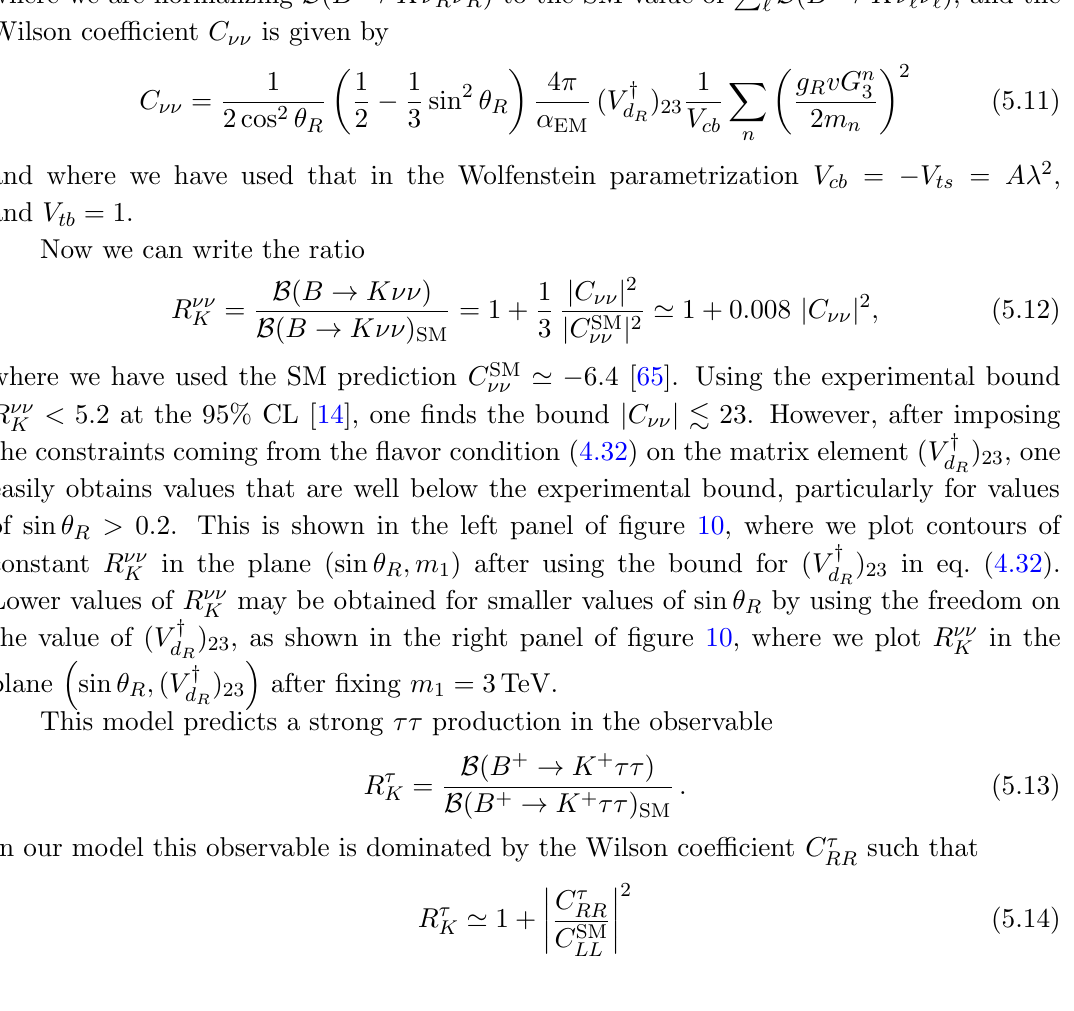
Figure 10 . Left panel: contour lines of constant R (cid:23)(cid:23) ( V y ) 23 = 0 : 005 obtained by the condition given in eq. (4.32). Right panel: contour lines of R (cid:23)(cid:23) d R for m 1 = 3